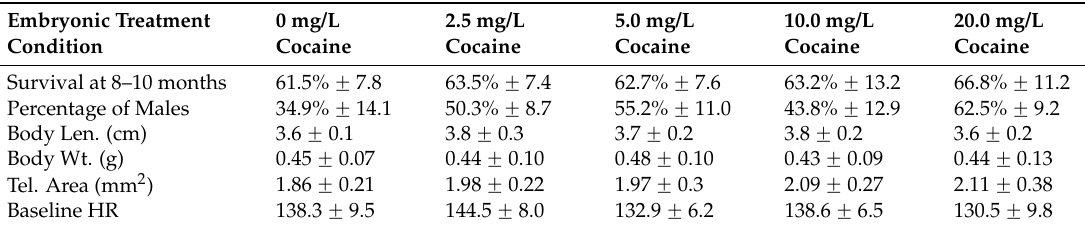
Table 2. Overall health of longitudinal adults treated with cocaine as embryos. Fish treated with one-way ANOVA with Dunnett’s post-test was used to compare embryonic treatment groups to the untreated control fish. For percentage survival at 8–10 months, p < 0.98, F = 0.080, df = 28. For the percentage of males, p < 0.55, F = 0.7748, df = 34. Fish were classified as either male or female, even in cases where the sex was ambiguous therefore the percentage of females can be inferred from this data as well. For body length (Len.), p < 0.205, F = 1.52, and df = 132. For body weight (Wt.), p < 0.420, F = 0.98, df = 132. For telencephalic area (Tel. Area), p < 0.16, F = 1.55, df = 84. For Baseline Heart Rate (HR), p < 0.7704, F = 0.4522, df =